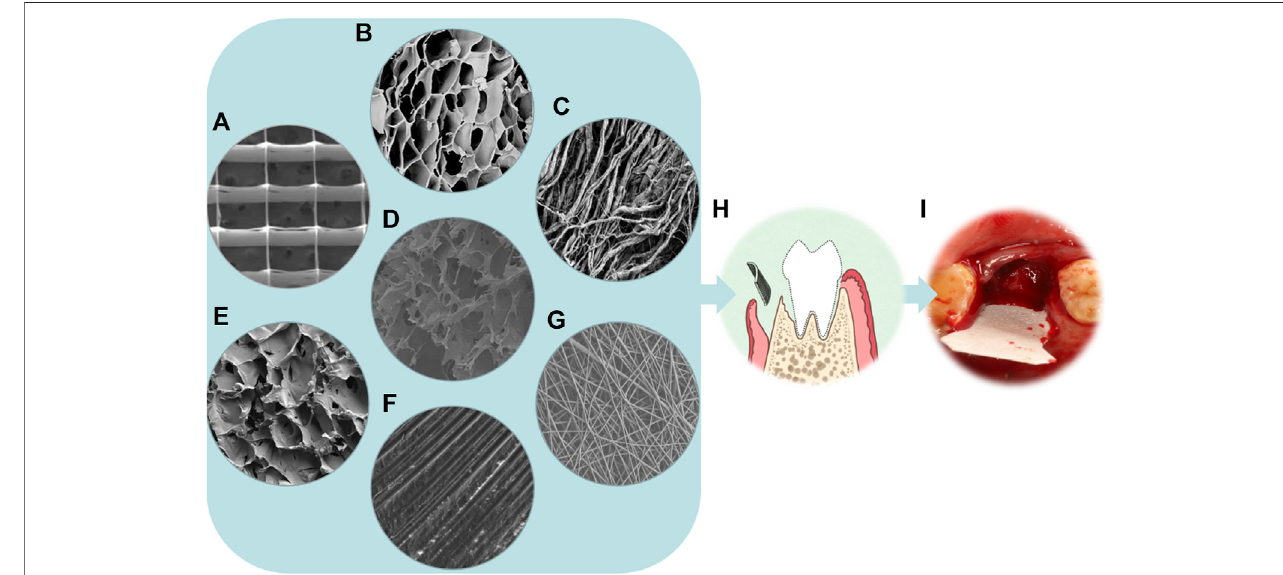
FIGURE 2 | From microscopy to reality of barrier membranes. (A) SEM micrograph of the PCL scaffold with the spacing of 500 µm (Dubey et al., 2020). (B) SEM micrograph of the γ -PGA/BC composite hydrogel (Dou et al., 2021). (C) SEM image of a rougher bottom layer with collagen strands of Bio-Gide (magni fi cation×1,000) (Wu et al., 2018). (D) SEM image showing the morphology of the loose layer of an asymmetric porous chitosan membrane (magni fi cation×2,000) (Ma et al., 2016). (E) SEM image showing the morphology of the loose cross-linked collagen layer of the aspirin-loaded chitosan nanoparticles contained in collagen-chitosan membrane (ACS-CCM) (Zhang et al., 2017). (F) SEM image ofthe dPTFE membrane (magni fi cation×500) (Korzinskaset al., 2018). (G) Field emission scanning electron microscopy(FE-SEM) images of PLGA/PCL electrospinning membranes (magni fi cation×1,000) (Qian et al., 2016). (H) Schematic illustration of the principle of GBR. (I) The implant placement procedure for BioGuide